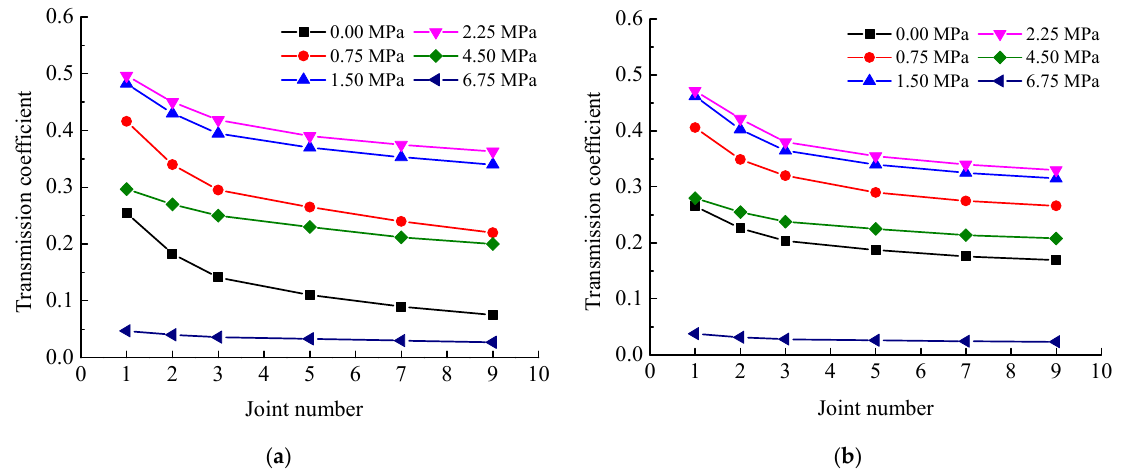
Figure 14. Transmission coefficient of the rock mass containing different numbers of 90° and 60° joints under biaxial static loads: ( a ) 90° jointed rock mass; ( b ) 60° jointed rock mass.